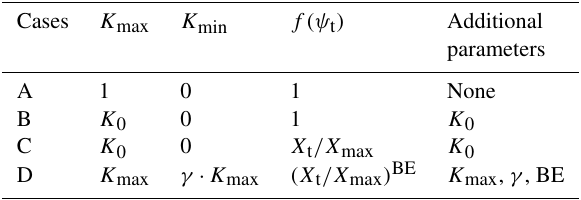
Table 1. K function in different